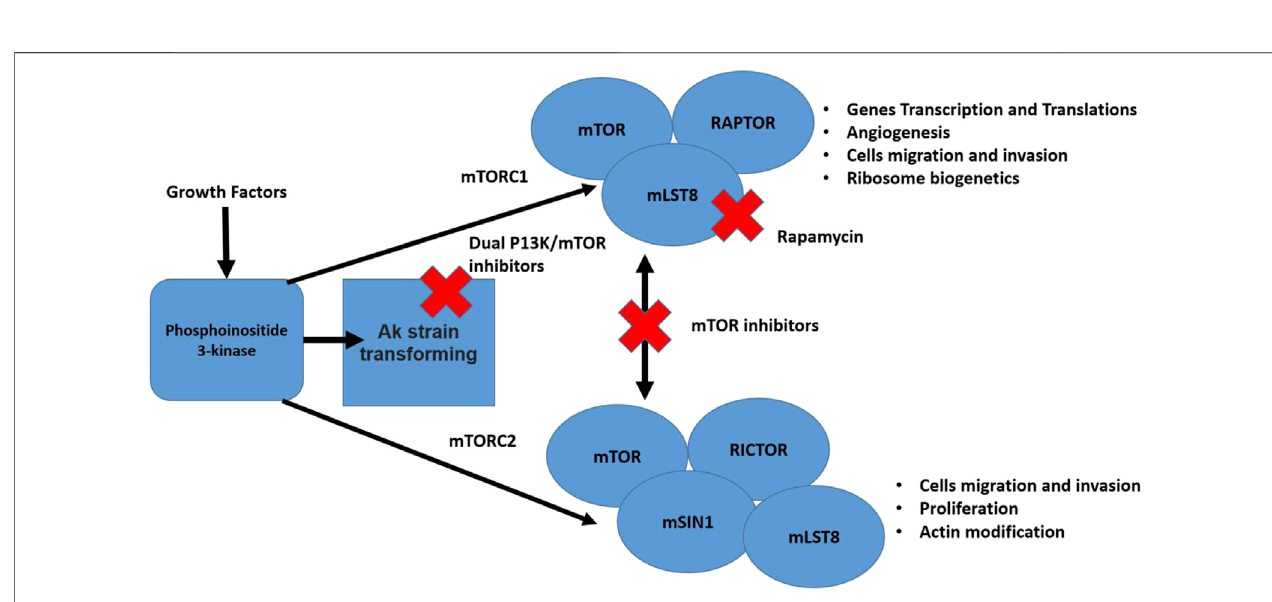
FIGURE 4 | The mTor pathway illustrating two distinct complexes (mTORC1 and mTORC2). The pathway is stimulated by different growth factors. The mTORC2 activatedAkt.Multiplecellfunctionsareregulatedbybothmentionedcomplexesthatareconsideredvitalforcancerdevelopment.Also,inthe fi guredifferentstepsofthe pathway that can be blocked by inhibitors are shown (Xie et al., 2016; Medina et al.,